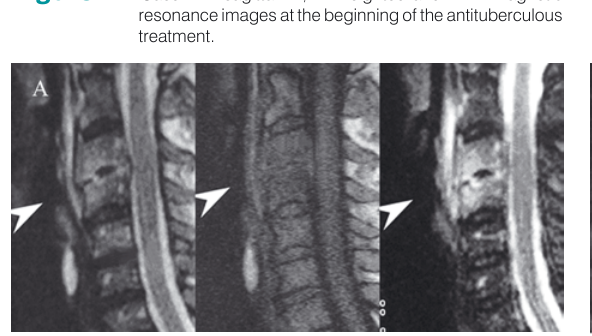
Figure 3. Case 2: A sagittal T1, T2-weighted and TIRM magnetic resonance images at the beginning of antituberculous